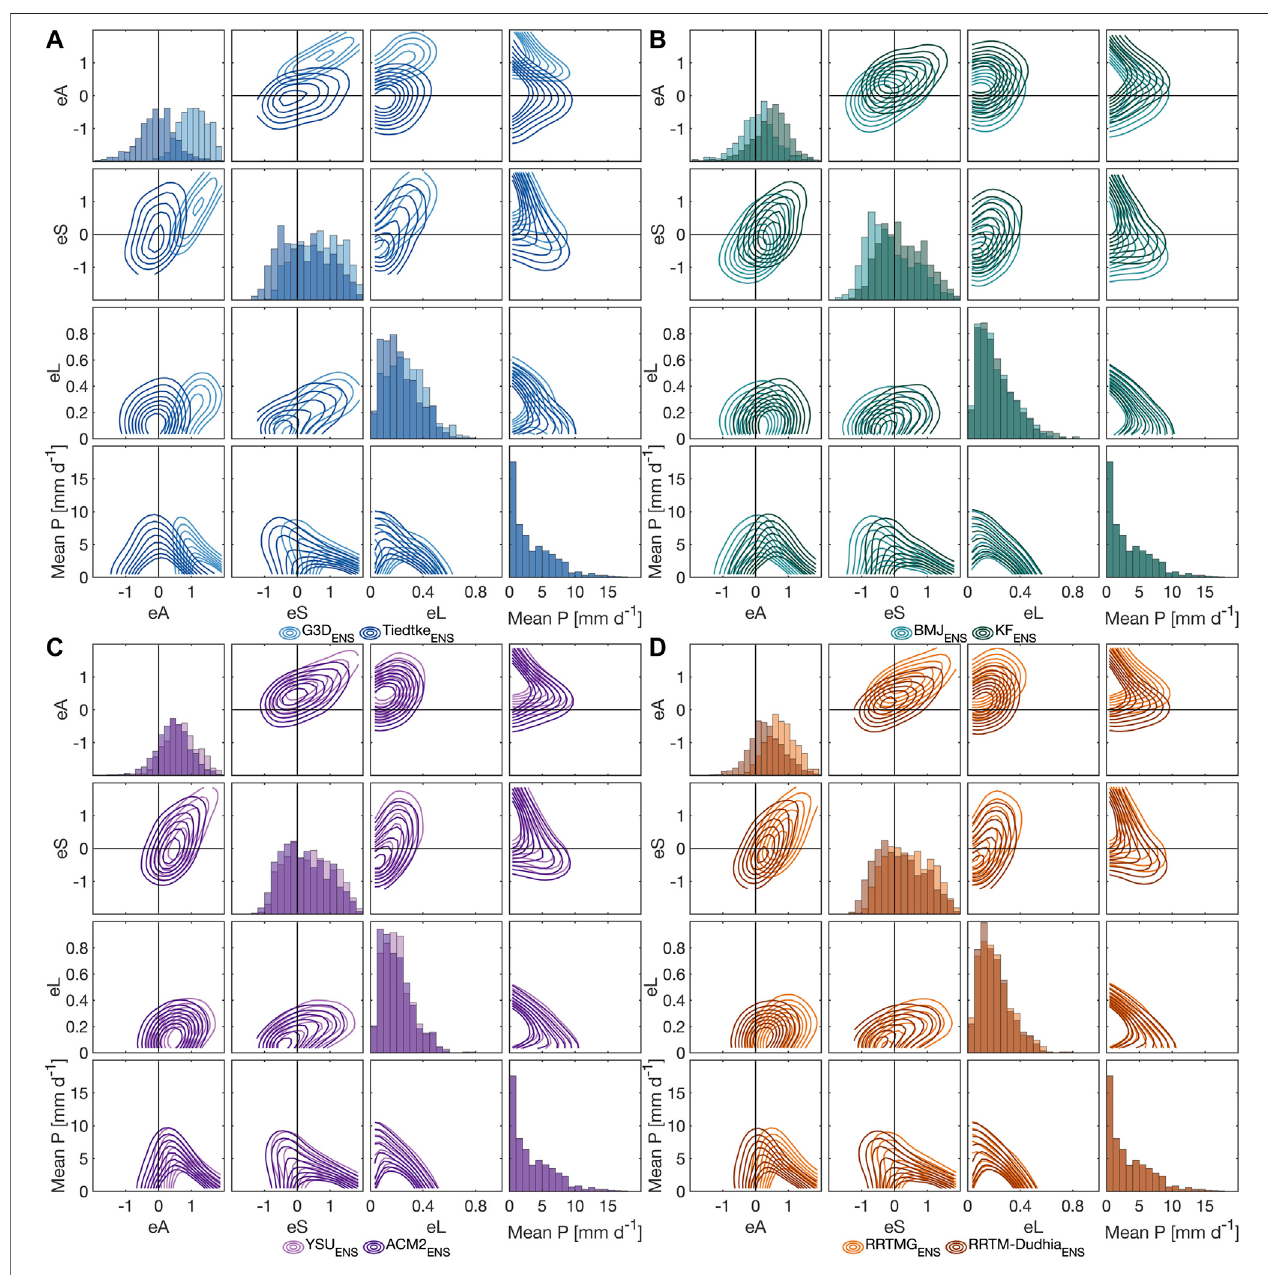
FIGURE 11 | As Figure 10 , but for